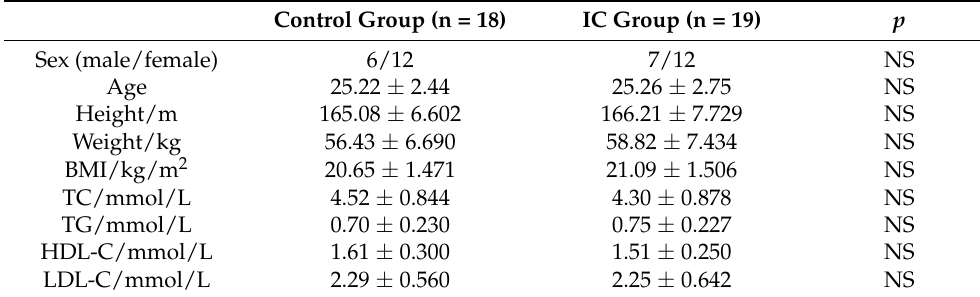
Table 2. Subjects’ baseline information on postprandial lipid